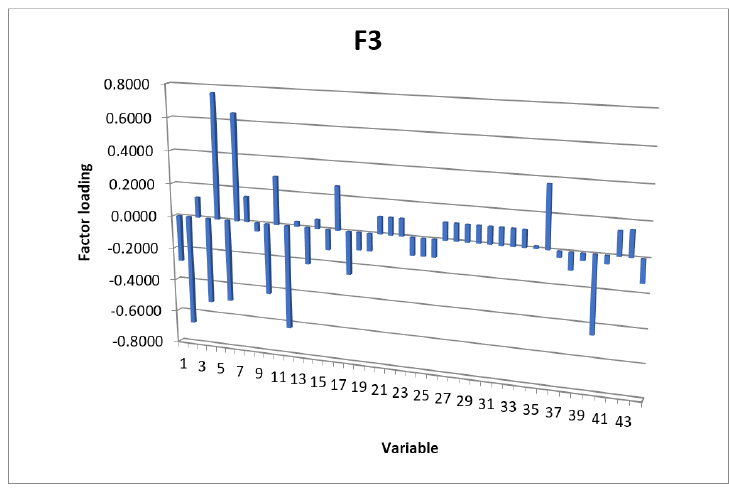
Figure 8. Graphic depiction of factor loads values for input variables for factor F3.